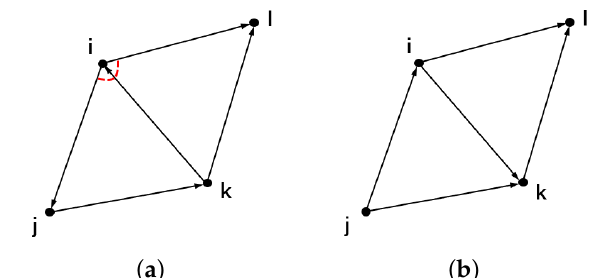
Figure 1. Two minimally persistent graphs. ( a ) A general minimally persistent graph that may not satisfy FOV constraints. For instance, assume that α is π internal angle marked by red dotted line is greater than π each internal angle formed by two outward edges is no more than π